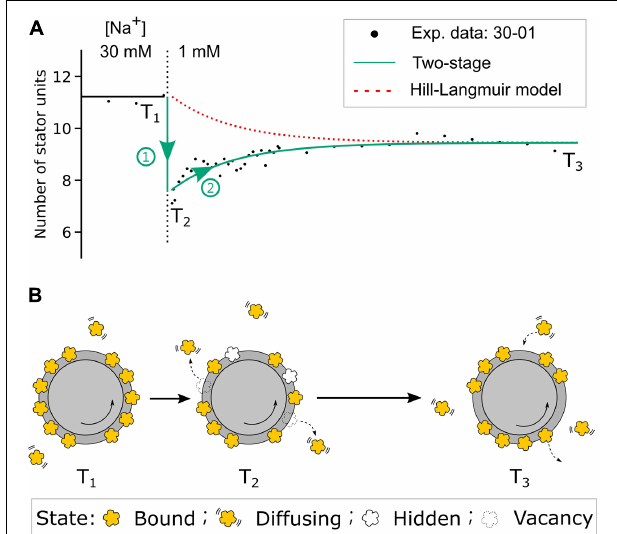
FIGURE 6 | The two-stage stator unit response model. (A) The comparison of stator unit numbers dynamics in the step-down 30-01 mM [Na] ex experiment from the two-stage model and the Hill–Langmuir absorption model. Black dots are the experimental data of stator unit numbers. The red dotted line represents the expected stator unit number transition from the Hill–Langmuir absorption model. The green line represents the time course of stator unit number in the two-stage model. T 1 and T 3 are the time points of motors at [Na] ex = 30- and 1-mM steady state, respectively. T 2 is the time point right after the [Na] ex step-down. (B) Model diagram of the stator states at three time points. At time point T 1 , the number of stator units is dynamically balanced on the motor. Right after the [Na] ex step-down, stage 1 (green circle 1), the numbers of stator units reduced partially by stator units unbound and partially by stator units enter the bound-but-not-functioning hidden state. In the second stage (green circle 2), the stator units resurrect to the steady state until the motor reaches the new steady state at time point T 3 . As the new dynamic balance is formed, the average number of bound stator units is less than that at T 1